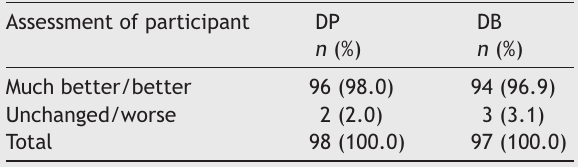
Adverse events reported by at least 1%